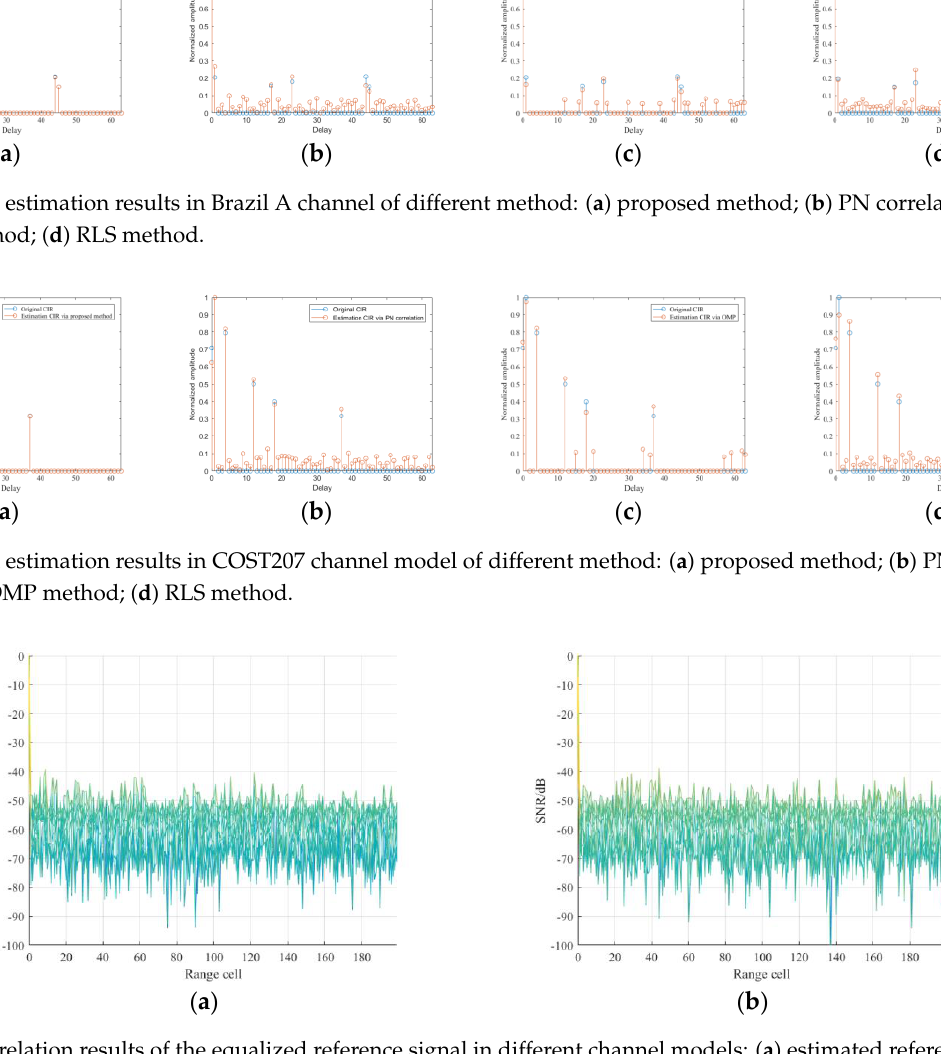
Figure 9. Correlation results of the equalized reference signal in different channel models: ( a ) estimated reference signal in Brazil A; ( b ) estimated reference signal in COST207.